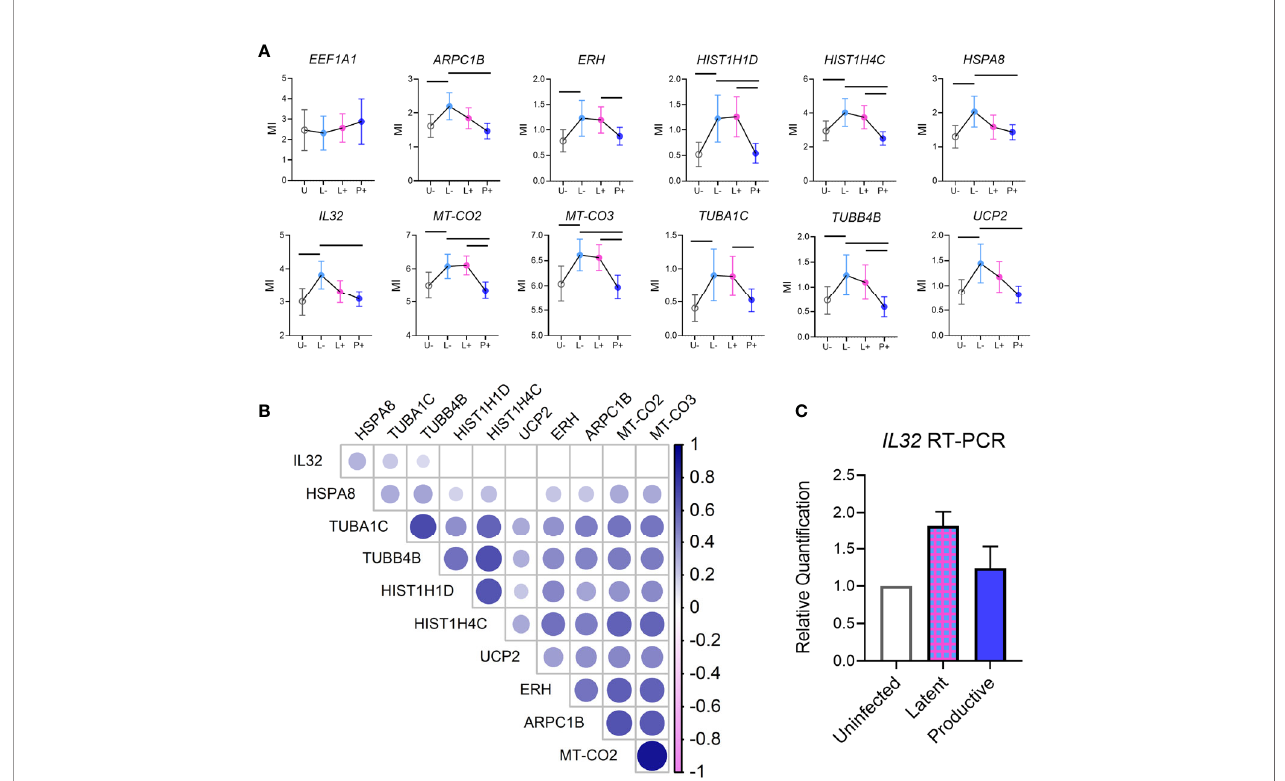
FIGURE 4 | Unique gene signature in latent cells. (A) Individual graphs showing mean (error bars indicate 95% Con fi dence Interval) expression of each of the genes identi fi ed in Differentially Expressed Gene analysis between Latent cells and other infected populations (from Figures 3B, C ). EEF1A1 expression (gray box, top left) was used as a control for EF1 a promoter activity in cells. (B) Correlation matrix showing the co-expression of each of the genes from (A) on a single cell level. Color intensity is associated with the spearman correlation coef fi cient and the size of circle is related to the p value (larger circle, smaller p value). (C) Validation of IL32 expression in bulk sort-puri fi ed cells from 2 donors by